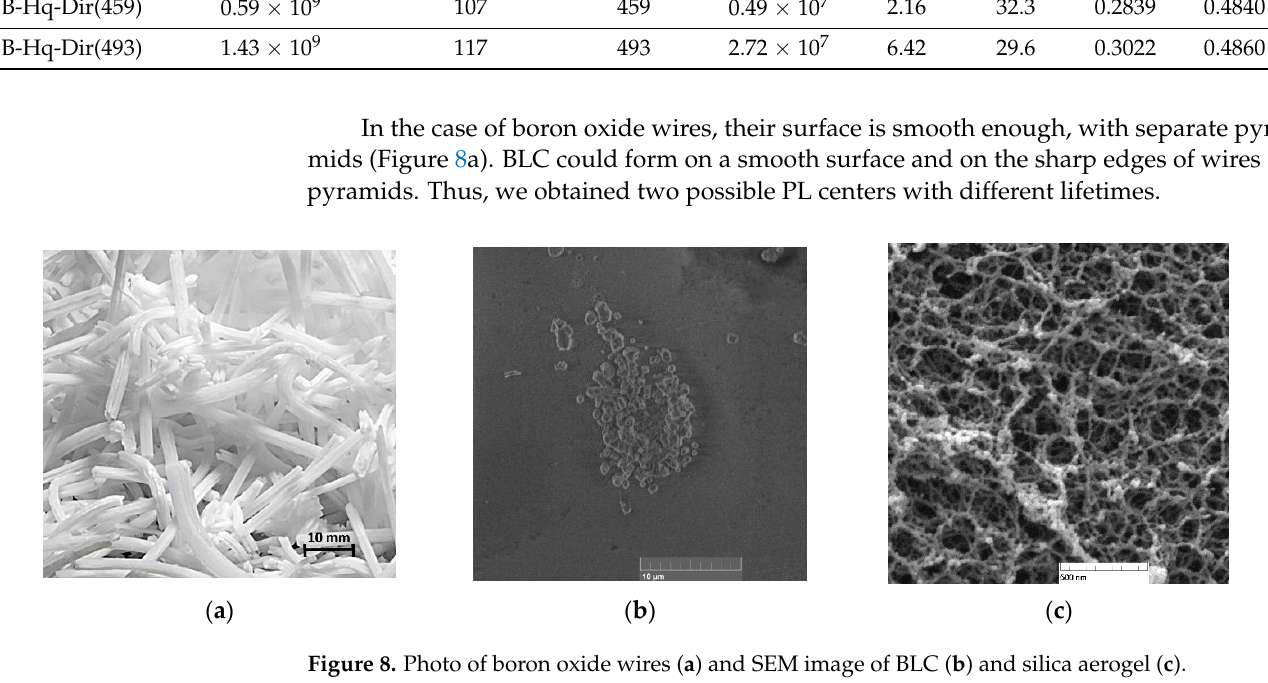
Figure 9. Scheme of the BLC formation of a smooth wire wall of boron oxide. On the sharp edges of ledges that existed on a smooth wire surface (Figure 8b), in accordance with steric factors, several 8-Hq molecules could interact with boron, resulting in a dimeric coordination compound with a brighter PL (B-Hq-Dir(493)) (Figure 10). Figure 10. Scheme of the BLC formation on the sharp edges of ledges of boron oxide wires.